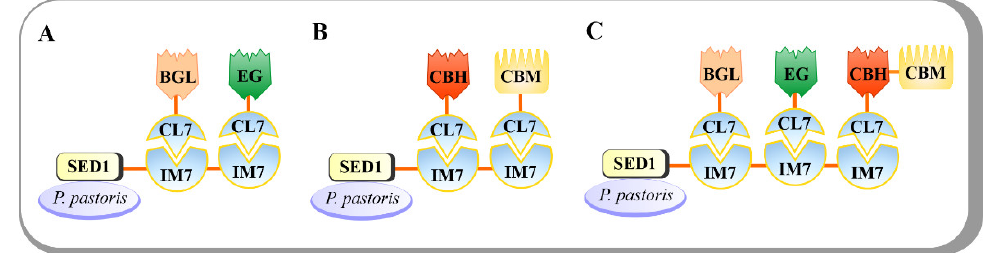
Figure 11. The novel ultra-high-affinity IM7–CL7 protein pair (K D ~10 −14 –10 −17 M) was used for cellulase assembly onto P. pastoris cell surface. ( A ) The engineered P. pastoris with one BGL and one EG enzyme on its surface. ( B ) The engineered P. pastoris with one CBH and one CBM on its surface. ( C ) The engineered P. pastoris with one CBH, one EG, one CBH, and one CBM on its surface.